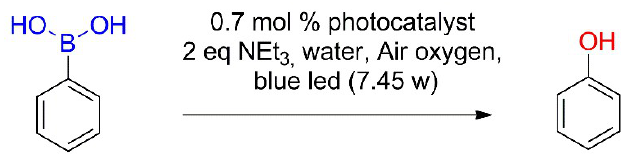
Figure 6. FRET efficiency E vs. molar ratio of Rh6G:SLNs, Rh6G 0.07 μM—0.07mM, SLNs 0.67 mM.